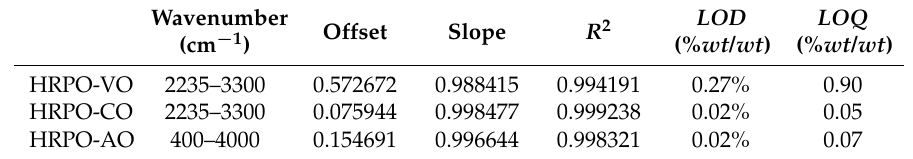
Table 1. Figures-of-merit of partial least squares (PLS) regression calibration